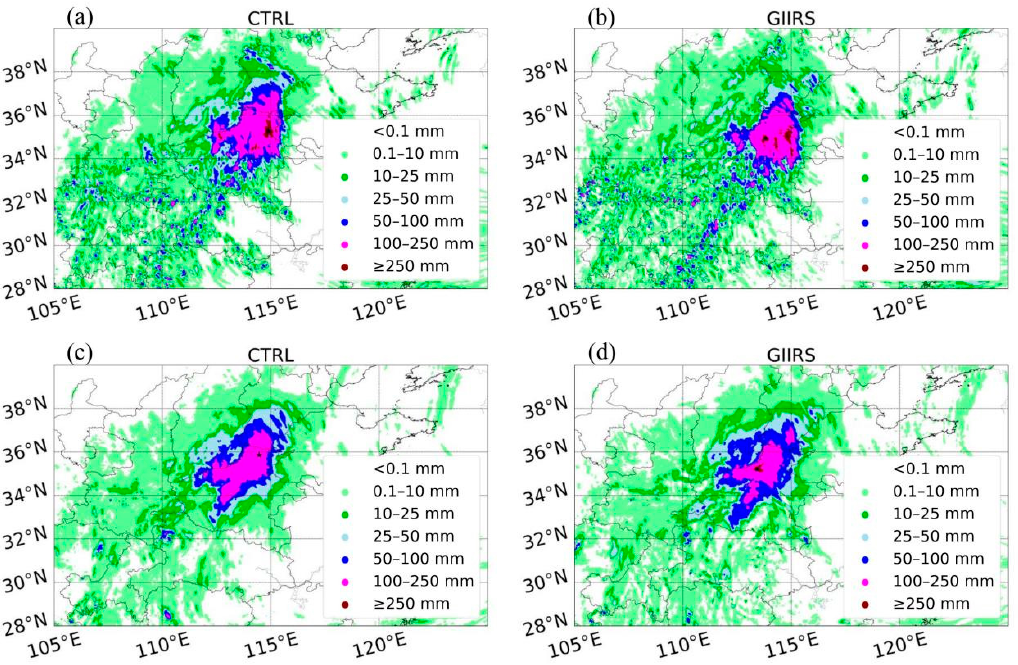
Figure 10. The predicted 24 ‐ h accumulated precipitation from 0000 UTC on 20 July 2021 to 0000 UTC on 21 July 2021 (shading; mm) by the CTRL ( a ) and GIIRS ( b ) experiments from the cold ‐ start at 0000 UTC on 19 July 2021. ( c , d ) are the same as ( a , b ), but for the warm ‐ start at 0600 UTC on 19 July 2021. The black dot represents the center of maximum precipitation.